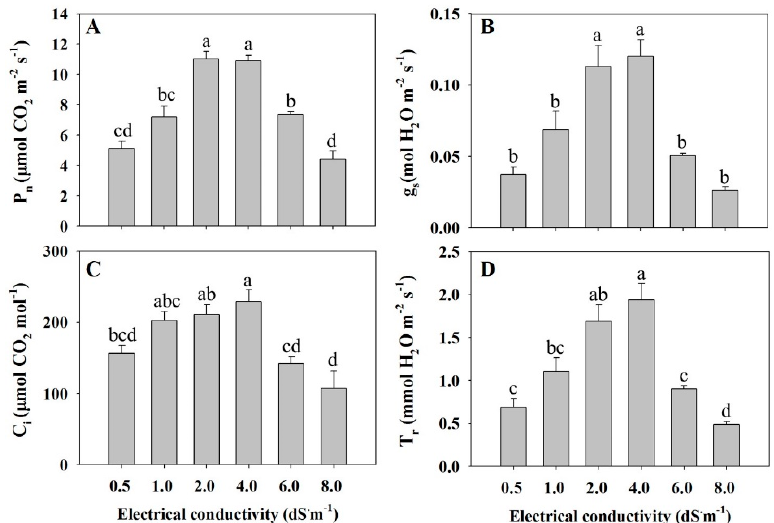
Figure 2. Net photosynthetic rate (P ) ( A ), stomatal conductance (g ) ( B ), intercellular CO 2 Figure2. Netphotosyntheticrate(P n )( A ),stomatalconductance(g s )( B ),intercellularCO 2 concentration n s (C i ) ( C ), and transpiration rate (T r ) ( D ) at di ff erent electrical conductivity (EC) treatments (0.5, 1.0, 2.0, concentration (C ) ( C ), and transpiration rate (T ) ( D ) at different electrical conductivity (EC) i r 4.0, 6.0, and 8.0 dS · m − 1 ). The data represent the means and the vertical bars show the standard error ( n treatments (0.5, 1.0, 2.0, 4.0, 6.0, and 8.0 dS·m − 1 ). The data represent the means and the vertical bars = 4). Di ff erent letters show significant di ff erences among EC treatments (Tukey’s test, p ≤ show the standard error ( n = 4). Different letters show significant differences among EC treatments (Tukey’s test, p ≤ 0.05).